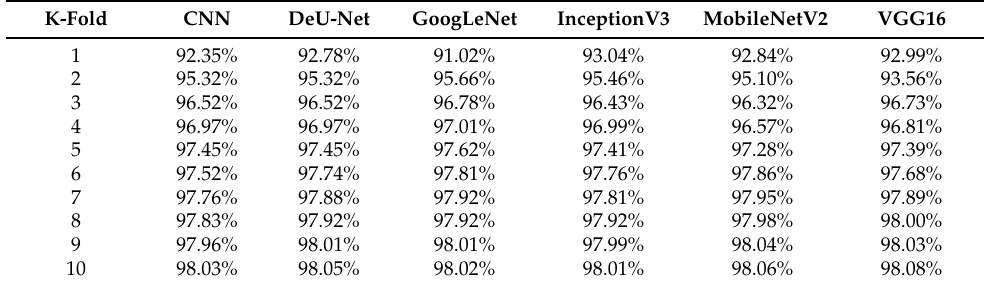
Table 3. Accuracy table of 10-fold cross validation.